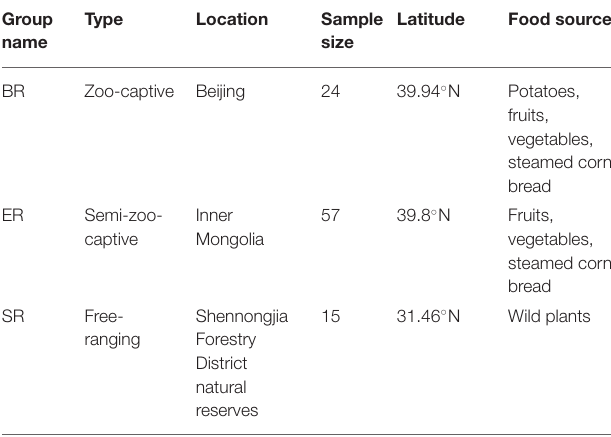
TABLE 1 | Sample location and size of zoo-captive and wild rhesus